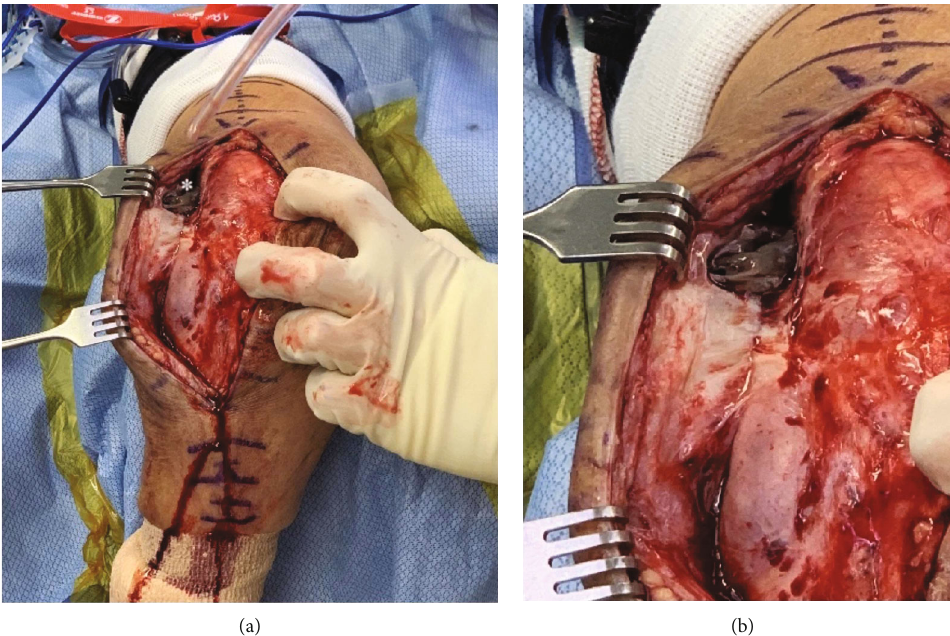
Figure 2: (a, b) Intraoperative images showing active infection at the time of the fi rst stage of revision surgery. (a) Posterior aspect of the left arm and elbow with abscess with a lateral paratricipital region and direct communication to a joint (white ∗ ) and (b) close-up of walled o ff abscess of the left